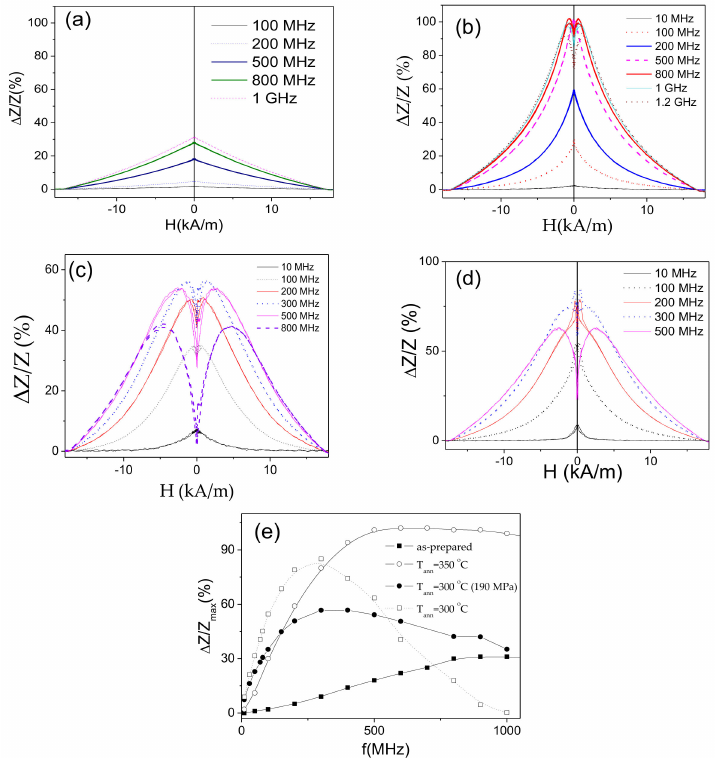
Figure10. ∆ Z / Z(H) dependenciesofas-prepared( a ); annealed( b )andstress-annealedat σ m = 190MPa( c ) at T ann = 350 ◦ C; annealed at T ann = 300 ◦ C for σ m = 0 MPa ( d ) and ∆ Z / Z m (f) dependencies of as-prepared, annealed at T ann = 350 ◦ C and stress- annealed at T ann = 300 ◦ C (190 MPa) ( e ) Fe 75 B 9 Si 12 C 4